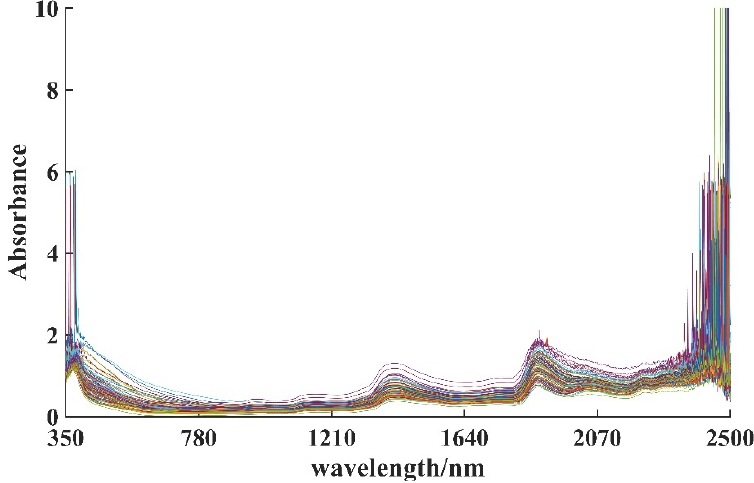
Figure 2. Full-band near-infrared spectrum of 96 samples from six tree species.